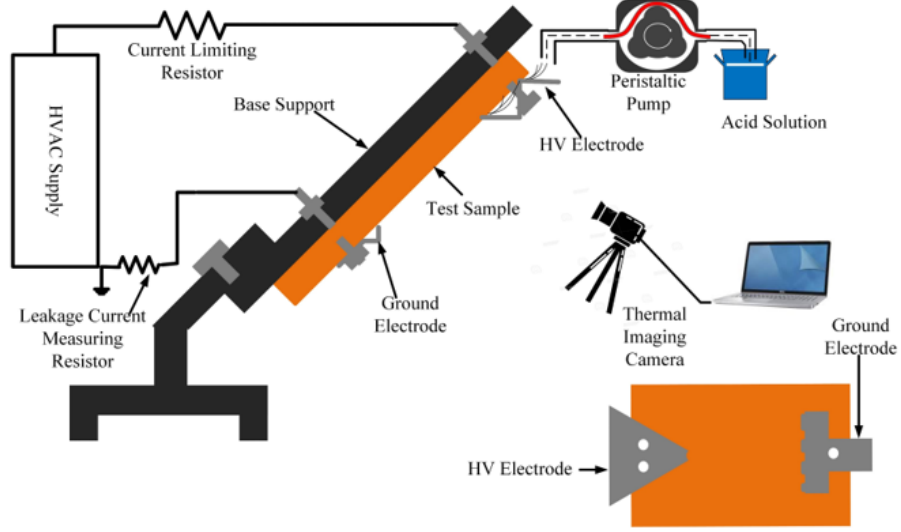
Figure 1. Arrangement for incline plane testing.